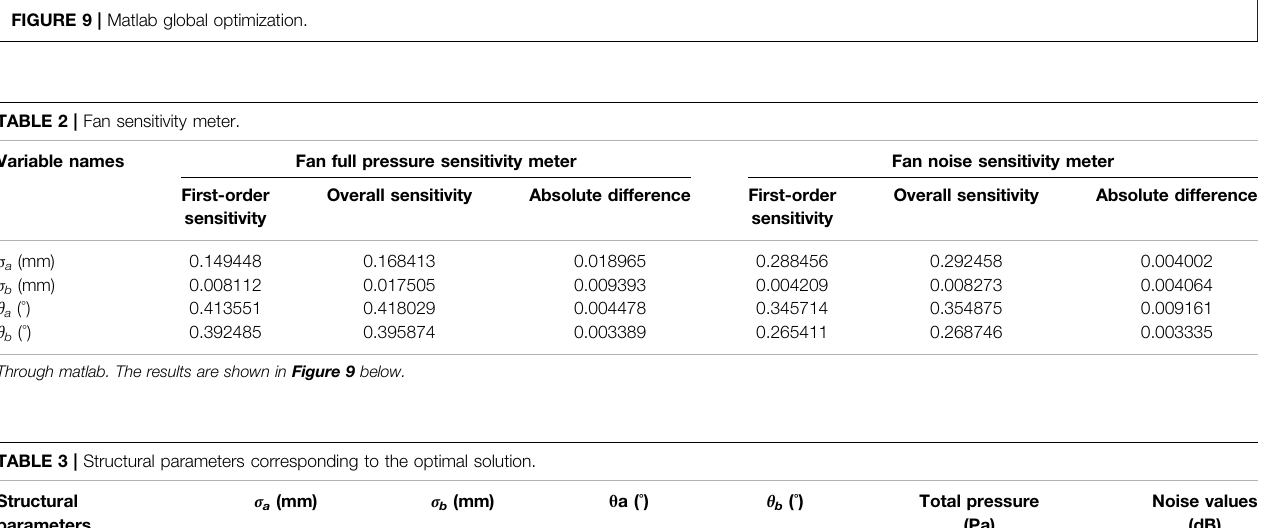
FIGURE 9 | Matlab global optimization.